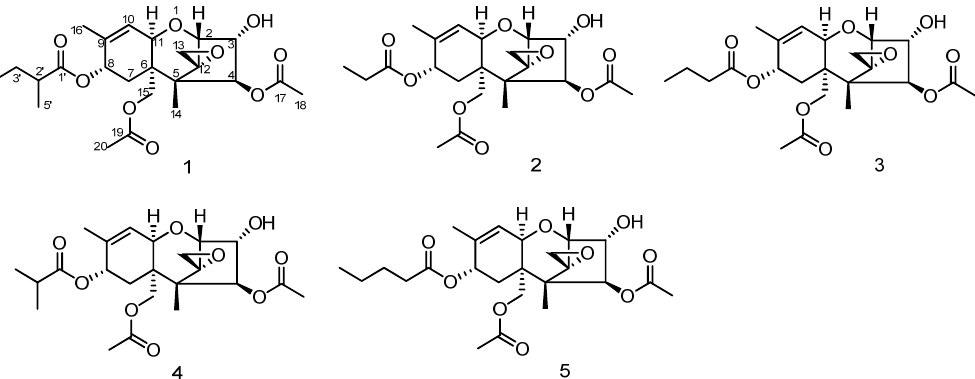
Figure 1. Chemical structures of the identified compounds 1 – 5 .